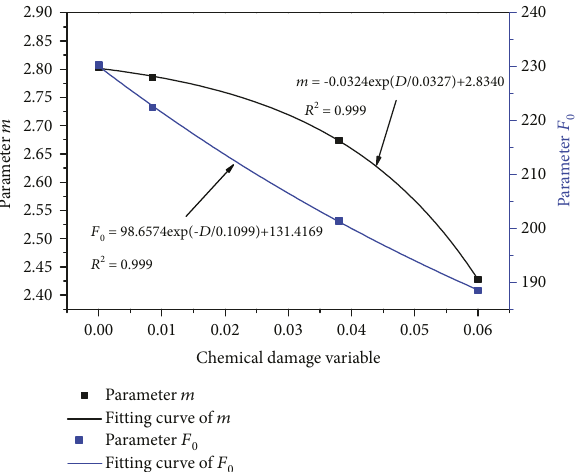
Figure 7: The variation of parameters m and F chemical damage